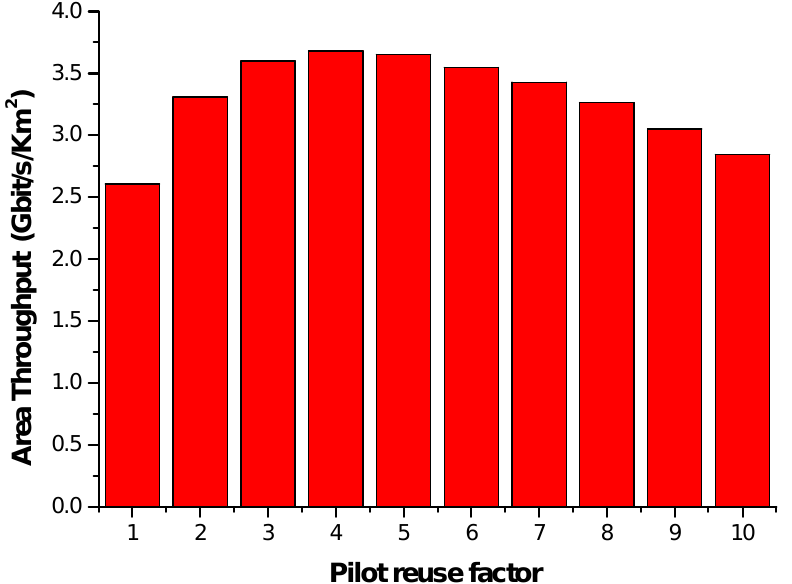
Figure 3. Area throughput for different pilot reuse